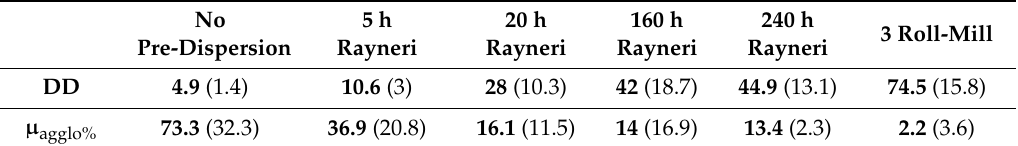
Table 1. Dispersion degree (DD) and micron-size agglomerates percentage ( µ agglo%) for the di ff erent